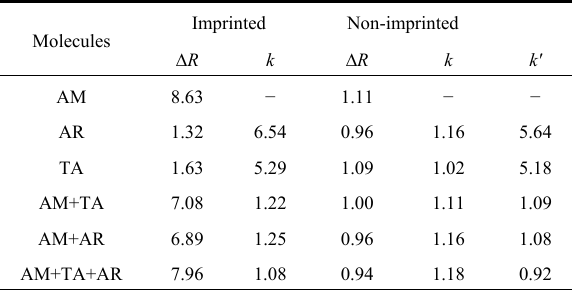
Table 2 Selectivity parameters.